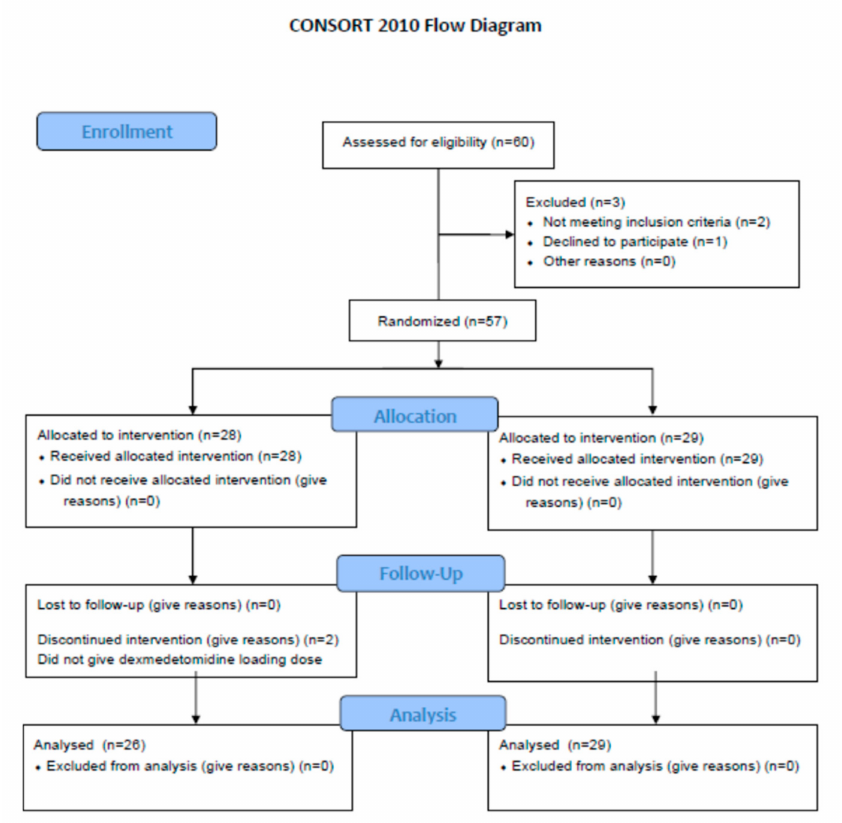
Figure 1. CONSORT